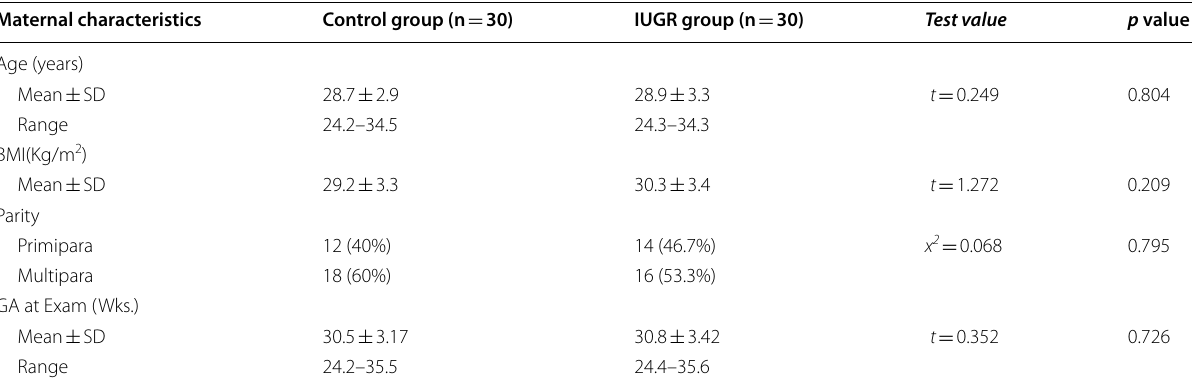
Table 1 Maternal characteristics among the control and IUGR groups